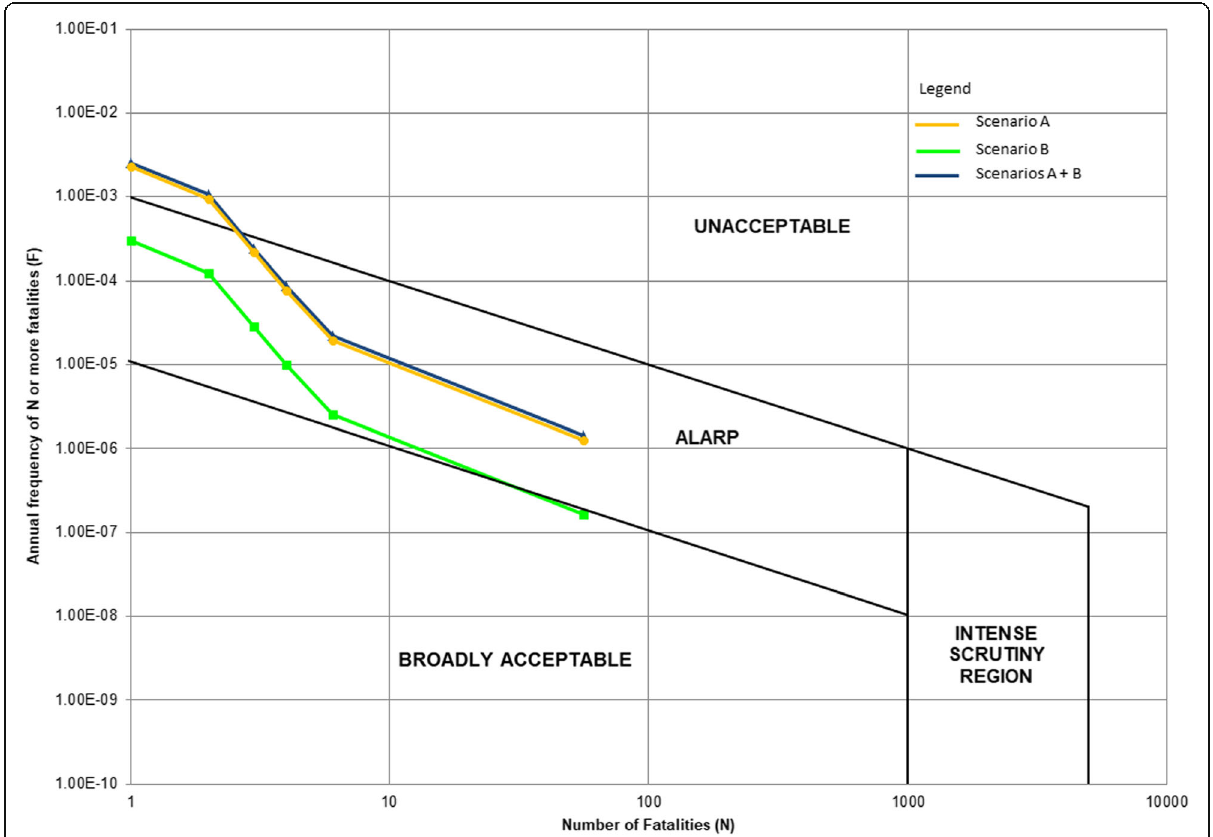
Fig. 12 F - N curves based on the Wong et al. (2004) approach for the A83, before mitigation measures (compare to Fig.